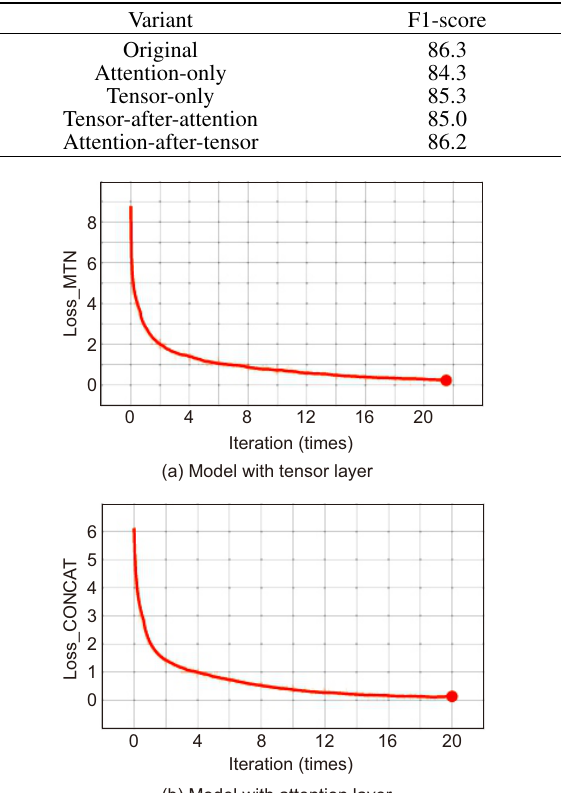
Table 4 Comparison of the variants.